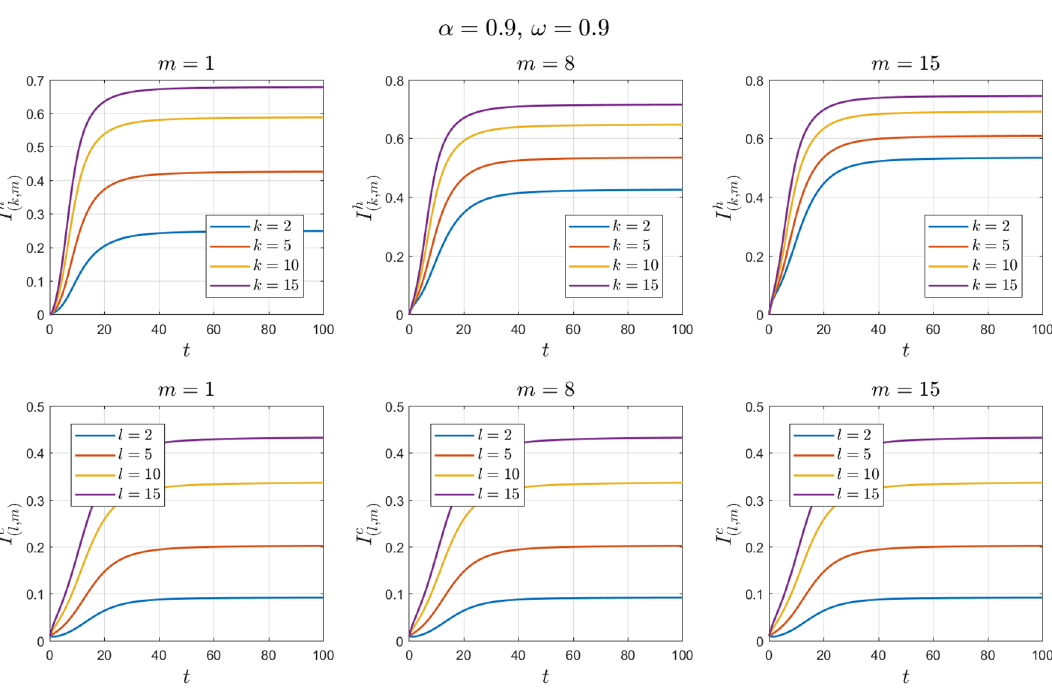
Figure 19. Numerical solutions of Example 5 for α = 0.9 and ω = 0.9